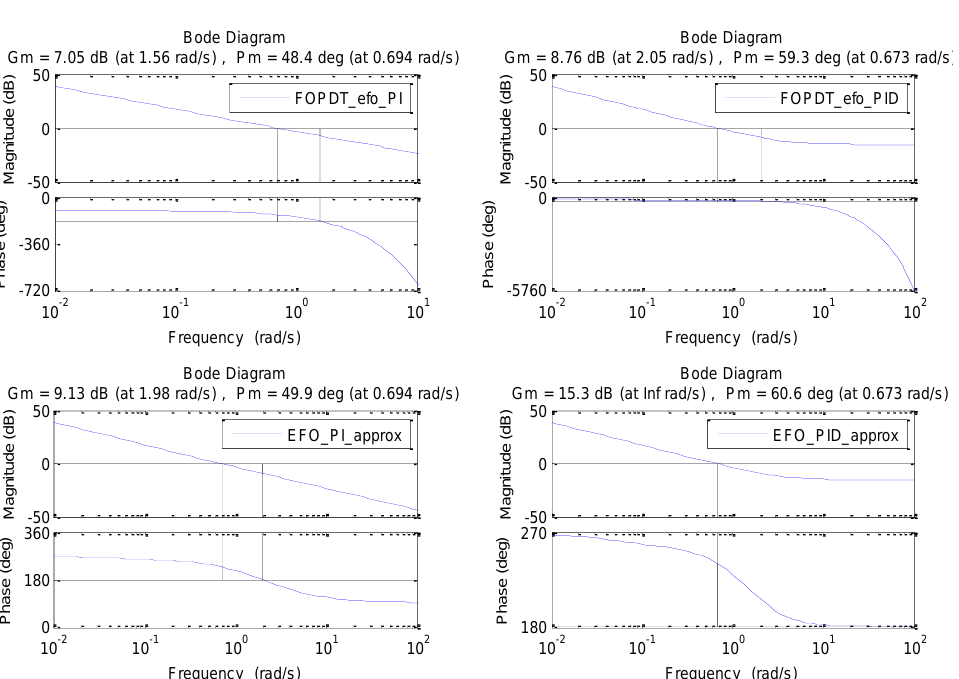
Figure 10. Bode plots of G(s) and G Pade’s (s) with EFO